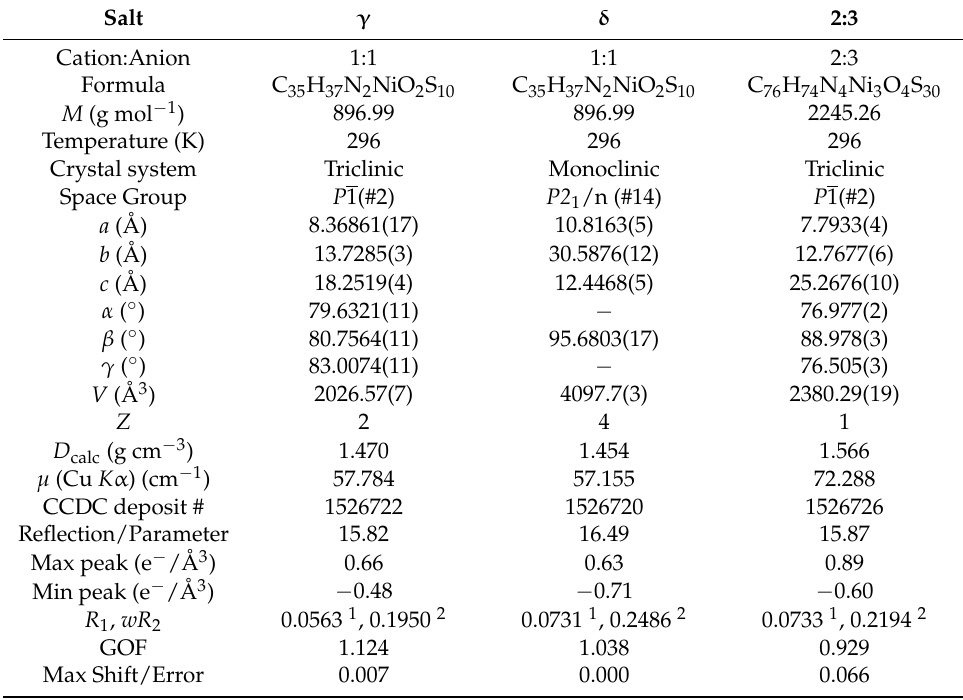
Table 1. Summary of crystallographic